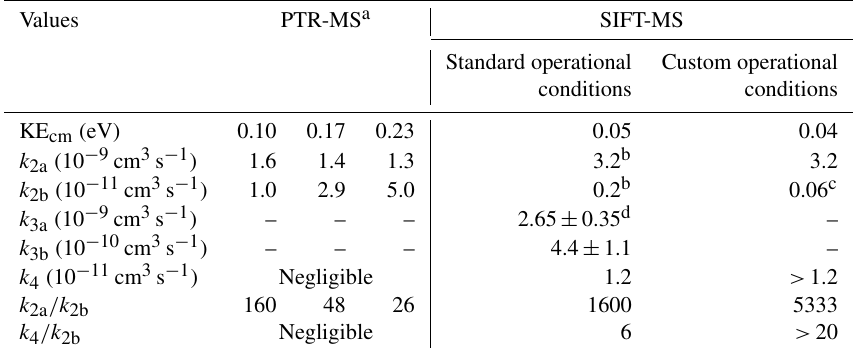
Table 3. Rate coefficients of ion molecule chemical reactions of FM under typical PTR-MS studies retrieved from the literature and the conditions in which SIFT-MS is deployed in this